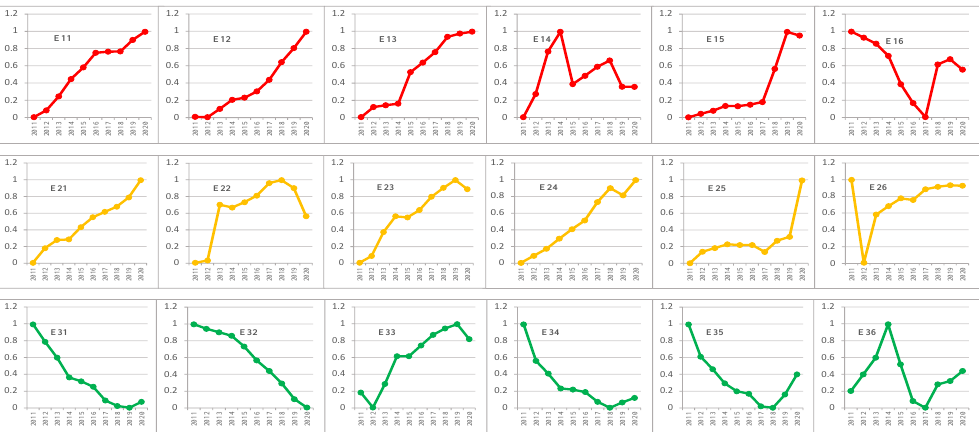
Figure 4. Orderliness of sequential parametric indicators of ESE-B composite system.